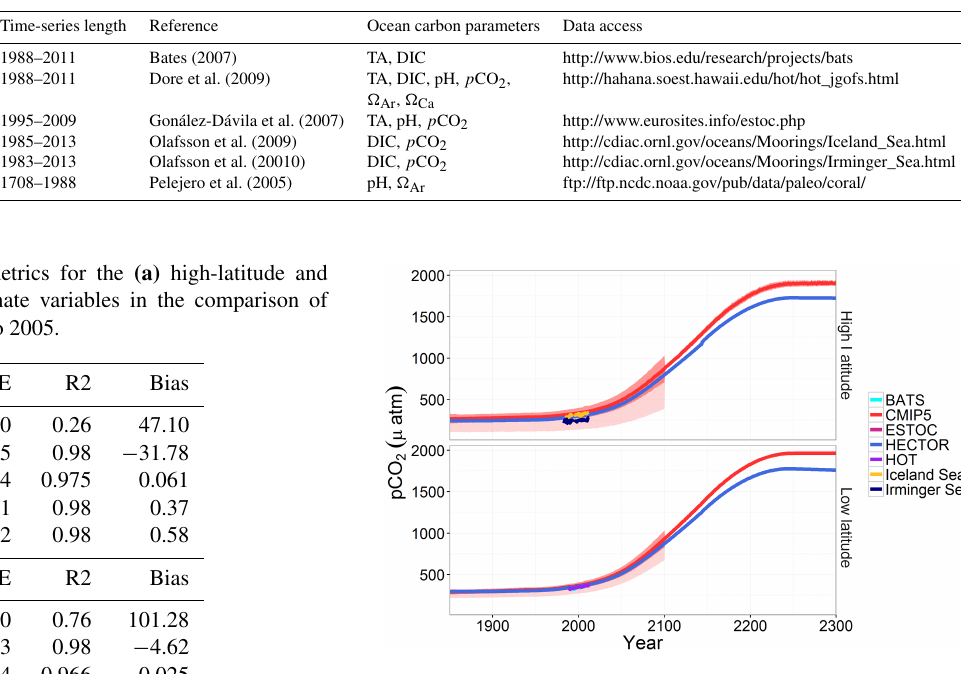
Figure 3. p CO 2 for high- (top) and low-latitude (bottom) surface ocean under RCP 8.5: Hector (blue), CMIP5 median, standard de- viation, and model range (red, n = 5 (1850–2100) and n = 2; 2101– 2300), as well as observations from BATS (teal), HOT (purple), ES- TOC (pink), Iceland Sea (yellow), and Irminger Sea